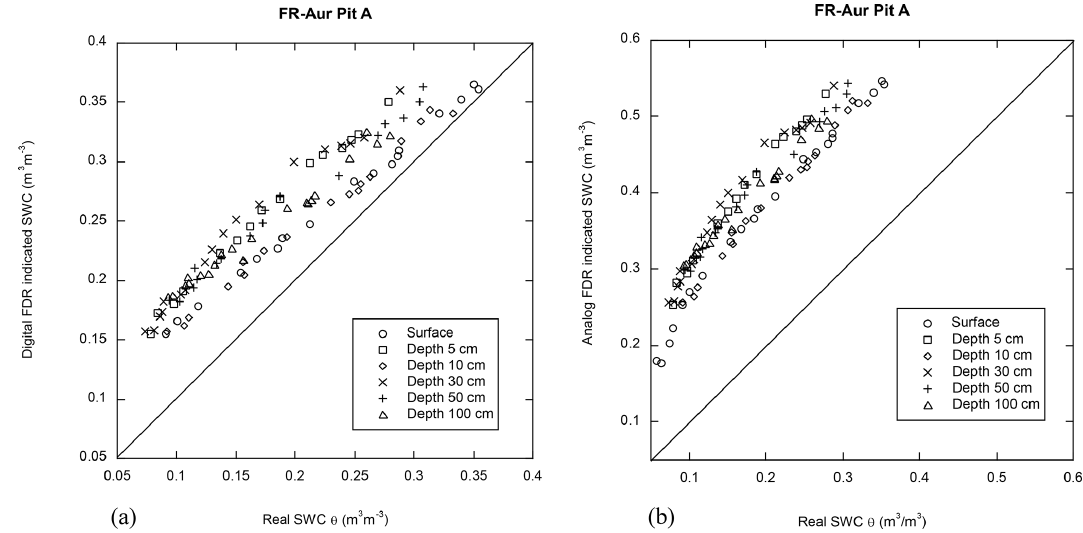
Figure 5. SWC estimated with (a) a factory-calibrated digital FDR sensor or (b) an analog FDR sensor, versus real SWC at several depths into Pit A at FR-Aur site.